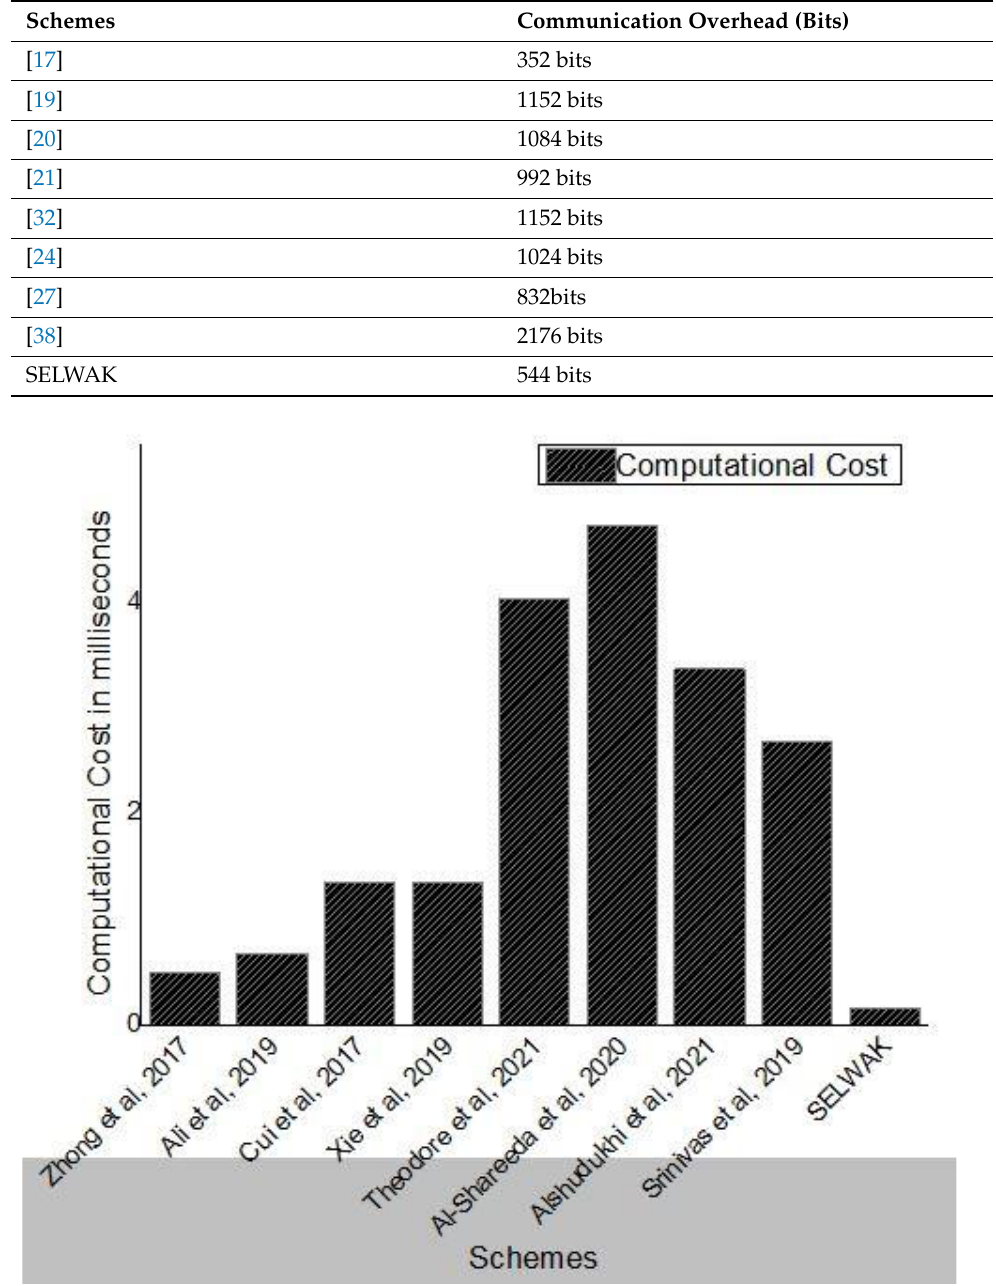
Table 3. Communication Cost Comparison.